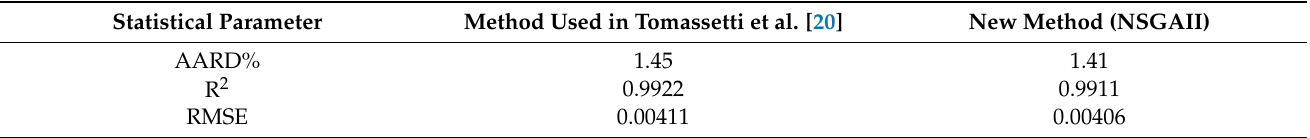
Table 3. Comparison between the results of the method used in Tomassetti et al. [20] and the new approach using the NSGAII algorithm.